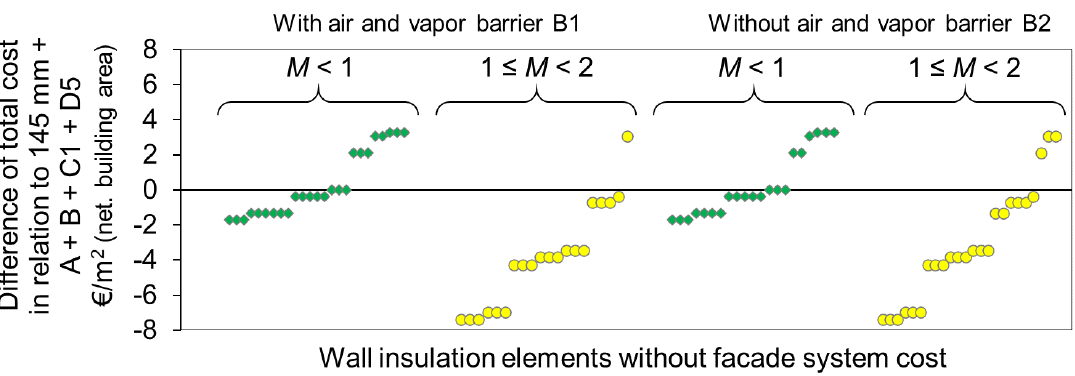
Figure 5. Influence of changing the total cost on the risk of mold growth without the contribution of facade systems to the cost of prefabricated element.